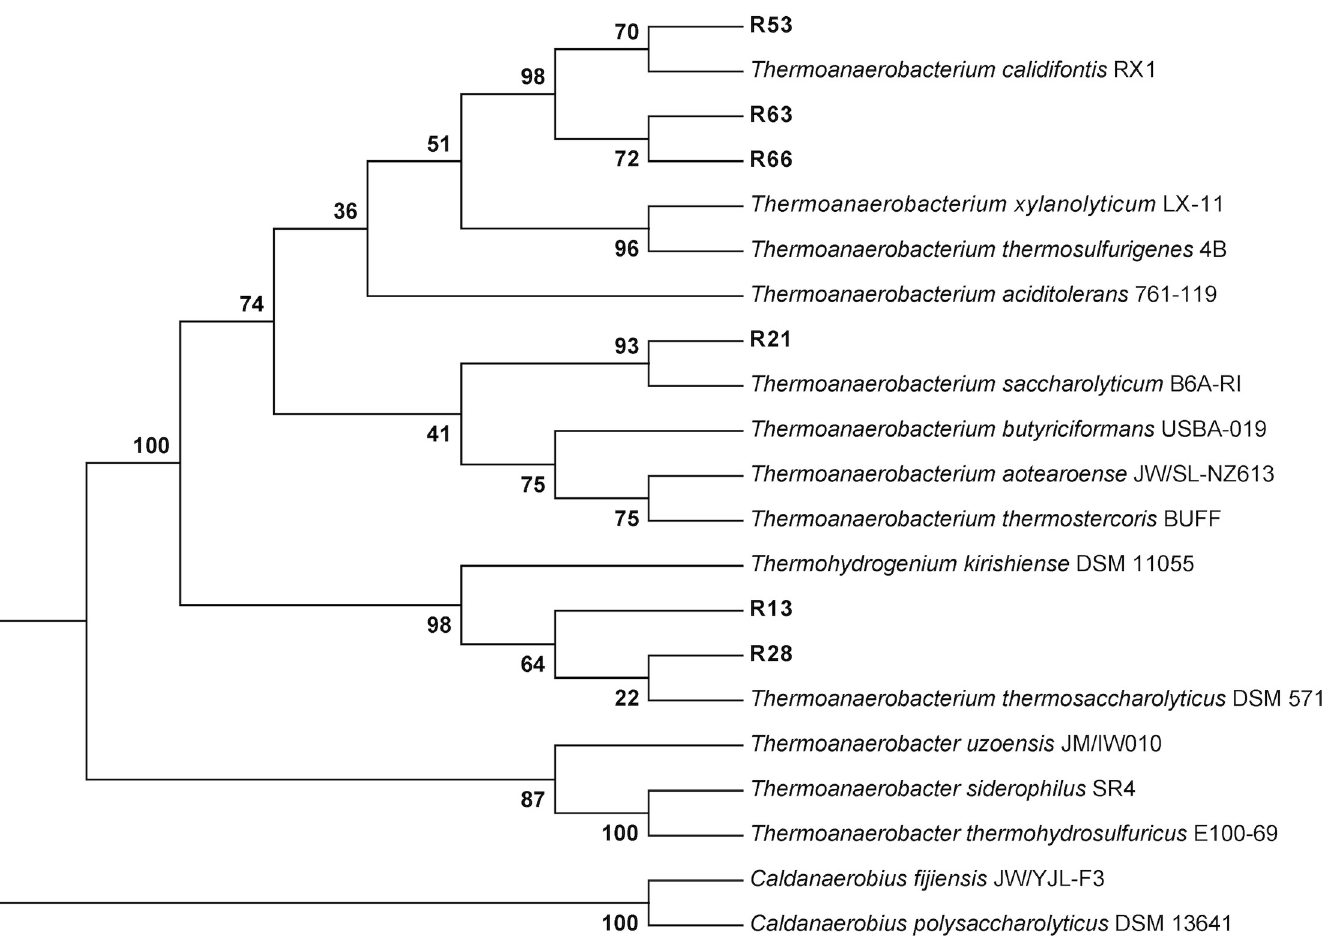
Fig 1. Neighbor-joining tree based on partial sequence of 16S rDNA. The tree showing the phylogenetic relationship of six bacterial isolates (in bold) and closely related thermophilic bacteria. Bootstrap values expressed as percentages from 1,000 replications are located at each node.